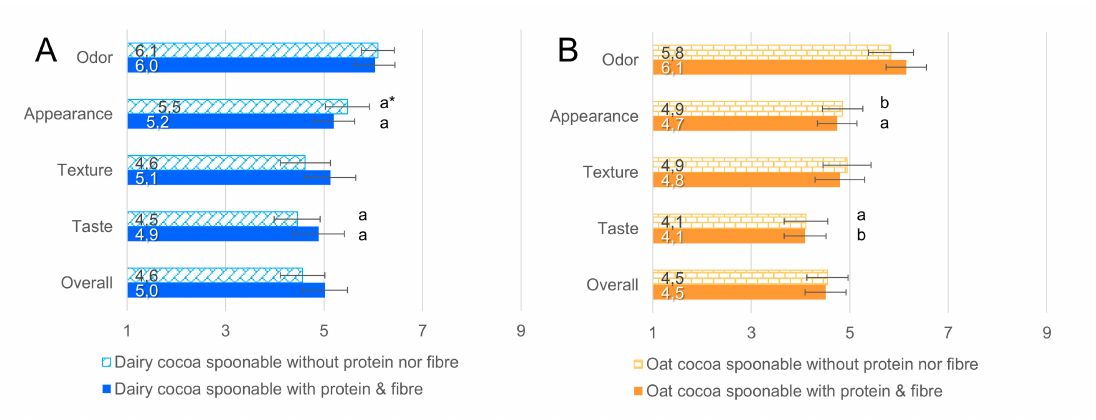
Figure 4. Bar charts of the average liking of dairy-based ( A ) and oat-based ( B ) cocoa-flavored spoonable samples. The charts are based on 55 responses. The 9-point hedonic scale was used for the evaluation of sample liking. Error bars are the 95% confidence intervals. * Sample types marked with di ff erent letters a,b have a statistically significant di ff erence between the likings of respective dairy- and oat-based samples ( p < 0.05, independent samples t